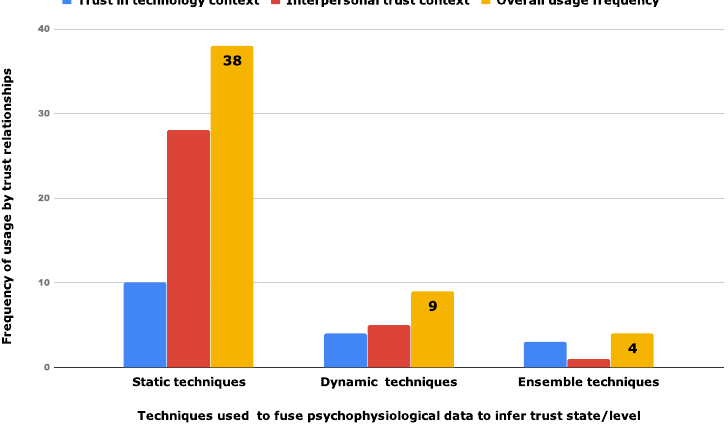
Figure 9. Most frequently used techniques for analyzing psychophysiological signals to infer